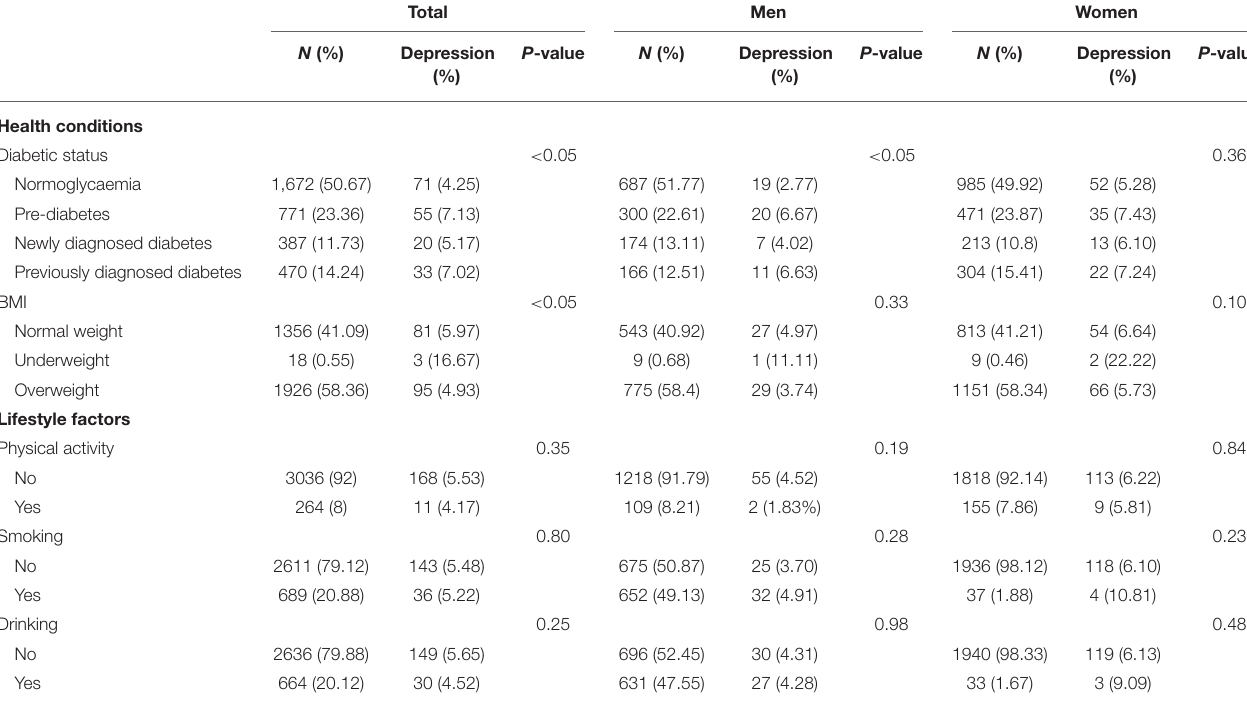
TABLE 3 | The characteristics of health conditions, lifestyle factors, and depression in analysis subjects. Total Men Women N (%) Depression P -value P (%)